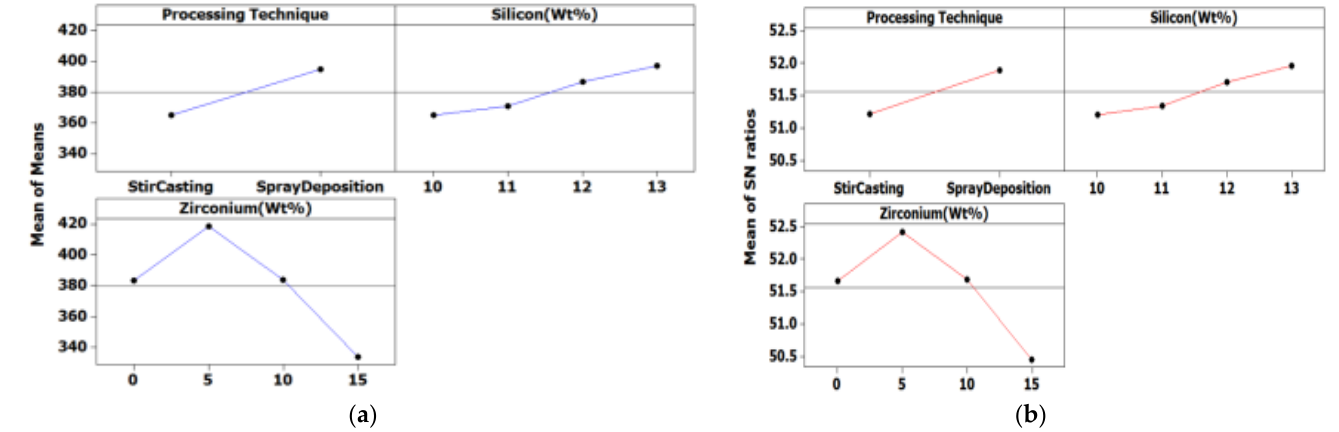
Figure 17. Main effects plot for ( a ) means and ( b ) SN ratio for compressive